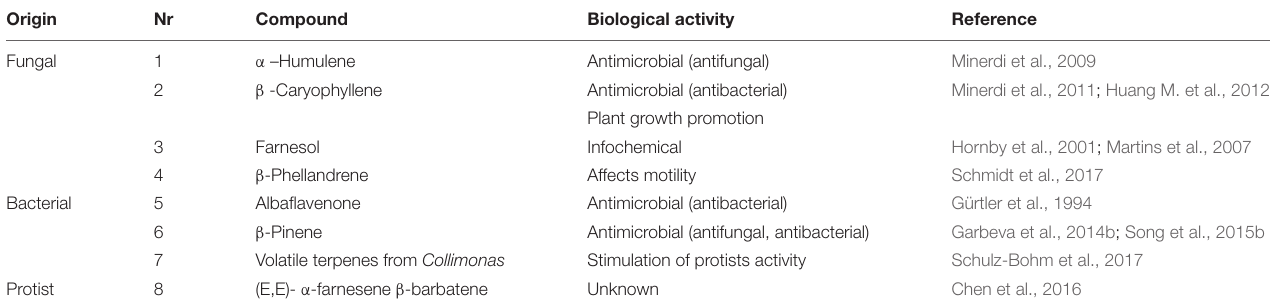
FIGURE 2 | Terpenes-mediated belowground interactions. The figure shows examples of interactions between different organisms in the rhizosphere that are mediated by microbial terpenes. Blue arrows indicate intra-kingdom interactions while black arrows indicate inter-kingdom interactions. The numbers in the figure correspond with the numbers in Table 1 . TABLE 1 | Examples of terpenes involved in belowground microbial